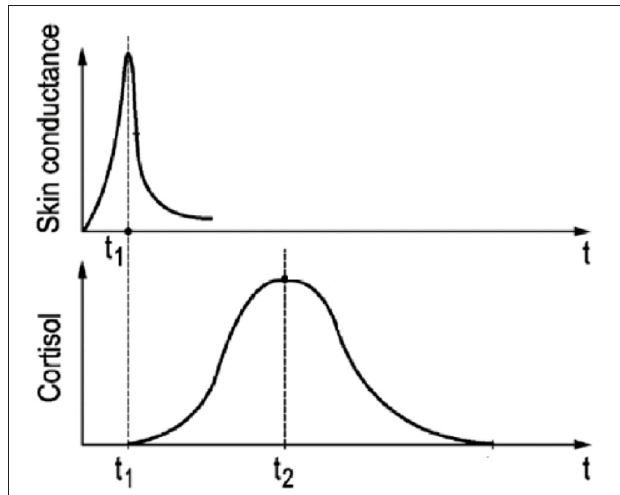
FIGURE 1 | Schematic graphical representation of the temporal relation between skin conductance response ( t 1 ) and the delayed cortisol response ( t 2 ) to a short-lasting psychological stressor ( t =